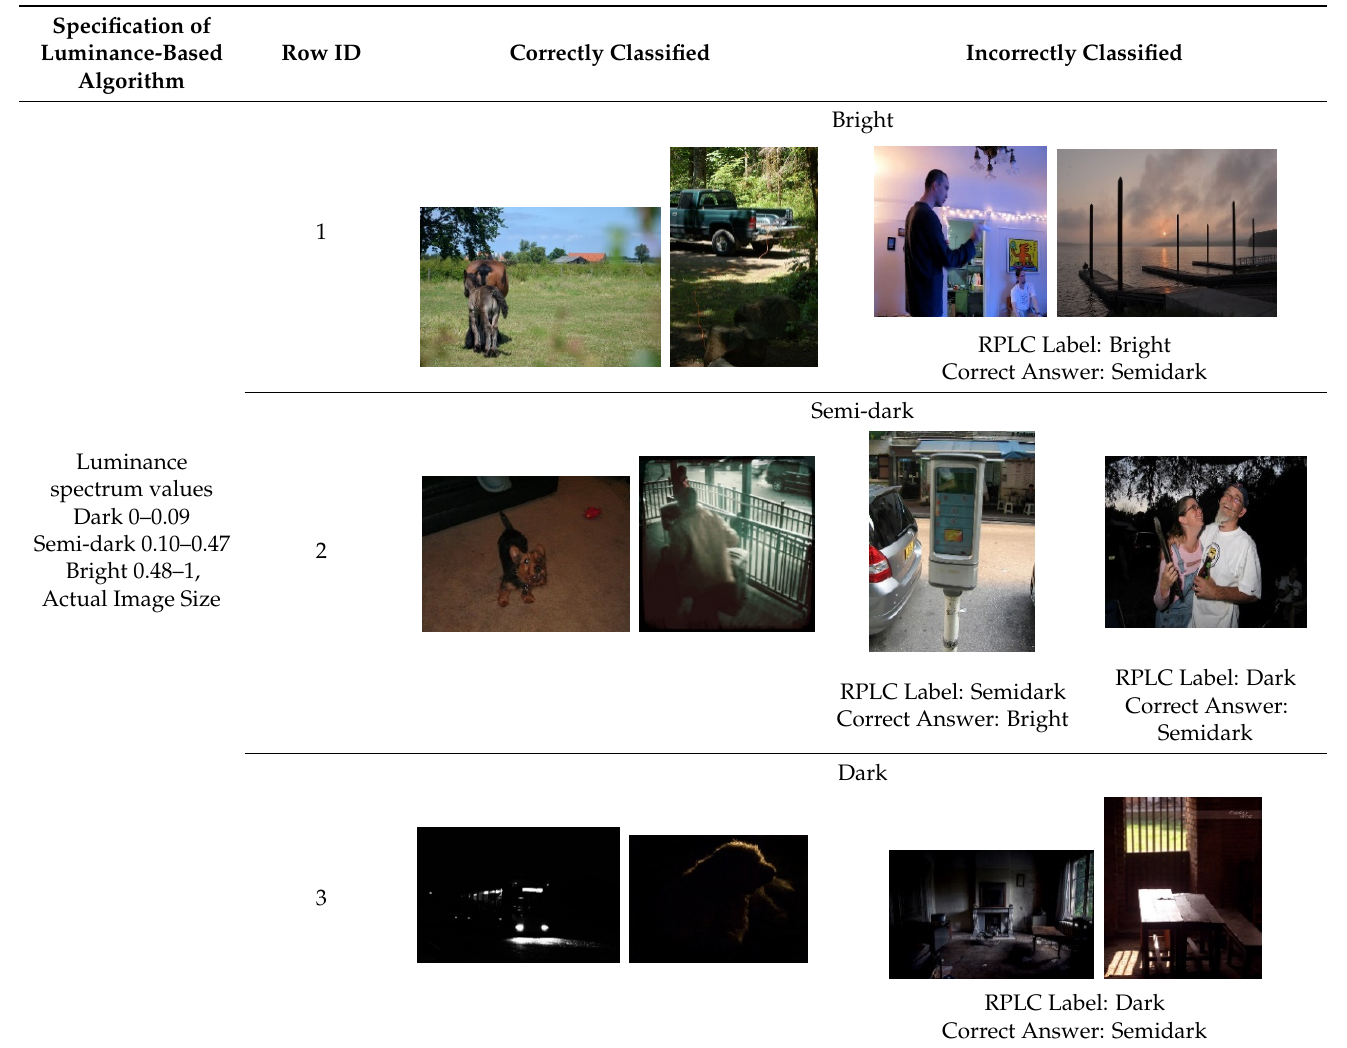
Table 5. Classification results of Table 5. Classification results of RPLC. Table 5. Classification results of RPLC. Table 5. Classification results of RPLC. Table 5. Classification results of RPLC. Table 5. Classification results of RPLC. Table 5. Classification results of RPLC. Table 5. Classification results of RPLC.